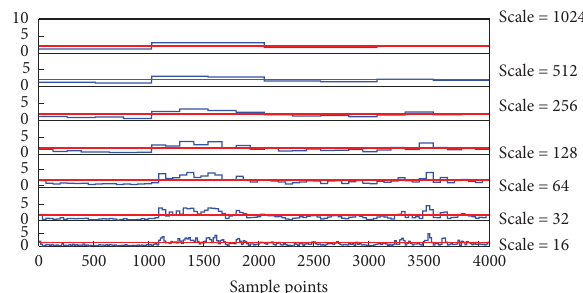
Figure 23: Wave at diferent scales.